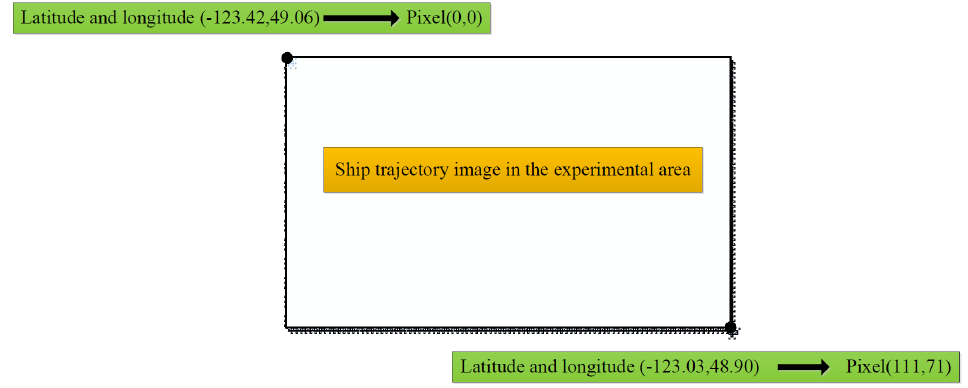
Figure 7. Schematic diagram of image pixels of latitude and longitude mapping.